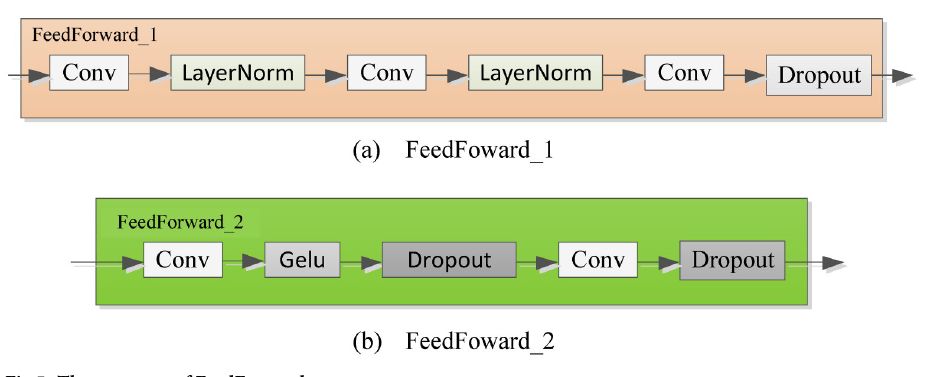
Fig 5. The structure of FeedForward.